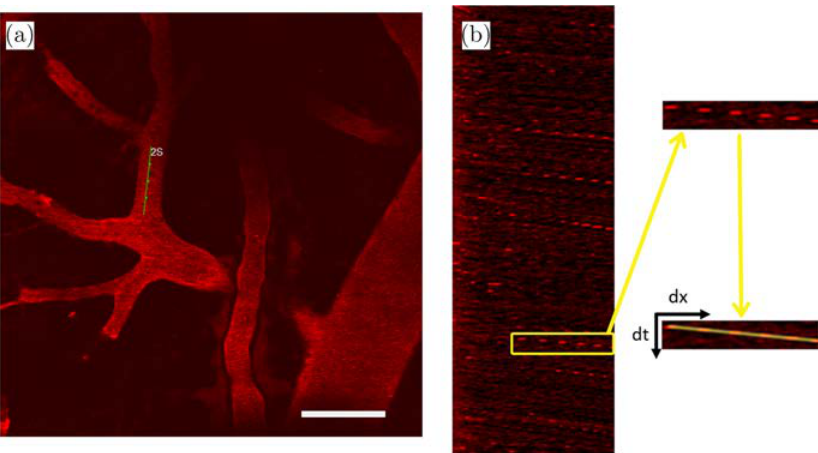
Fig. 8. Measurement of the blood °ow velocity in the rat brain. (a) An area for the line scan during 3PFM imaging, the scan line (2S) was parallel to the blood vessel. Scale bar: 100 (cid:1) m. (b) The enlarged image of a line scan image, dx/dt of one selected 3PF signal was computed to be (cid:1) 5 :